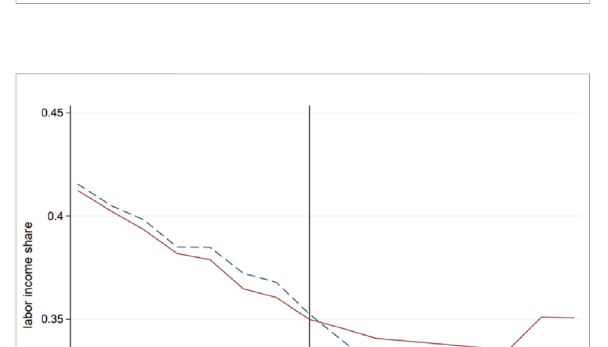
FIGURE 1 SO 2 emissions trend in 1997 – 2015.